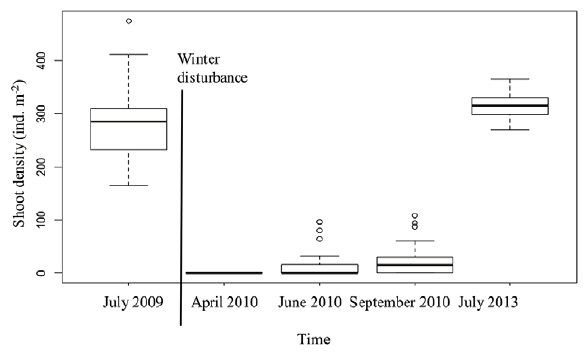
Fig. 3. – Shoot density (ind m –2 ) in a Zostera marina meadow at Ponta do Adoxe sampled in July 2009, before disturbance, and after disturbance in four periods from April, 2010 to July 2013.